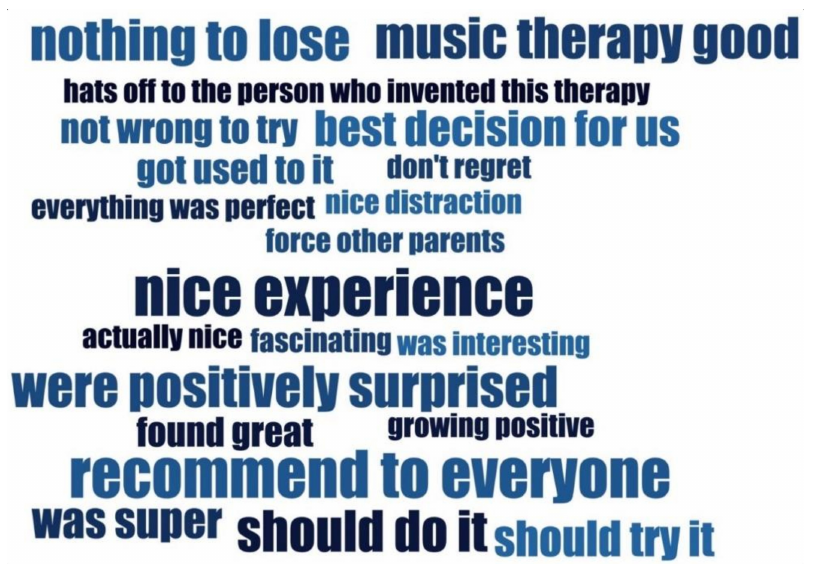
Figure 3. Code Cloud Parental Recommendations. Code cloud created with MAXQDA 2020 program; sub-codes from the code positive attitude toward music therapy are illustrated as a code cloud, in which the size of each sub-code and saturation correlates with the number of coded segments within the